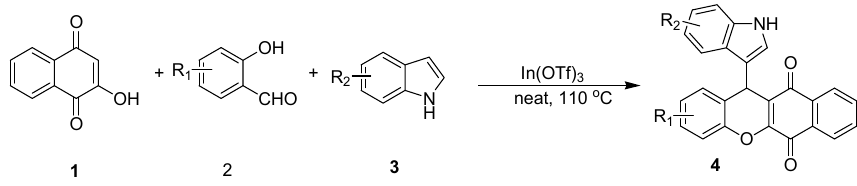
Table 1. Reaction conditions optimization for the synthesis 4a .